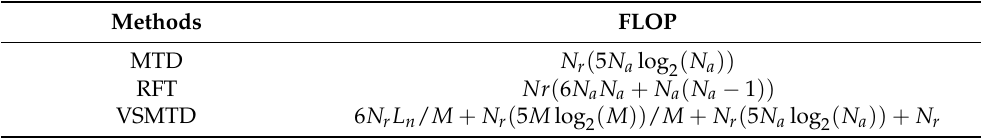
Table 1. Computational Complexity of All Methods.